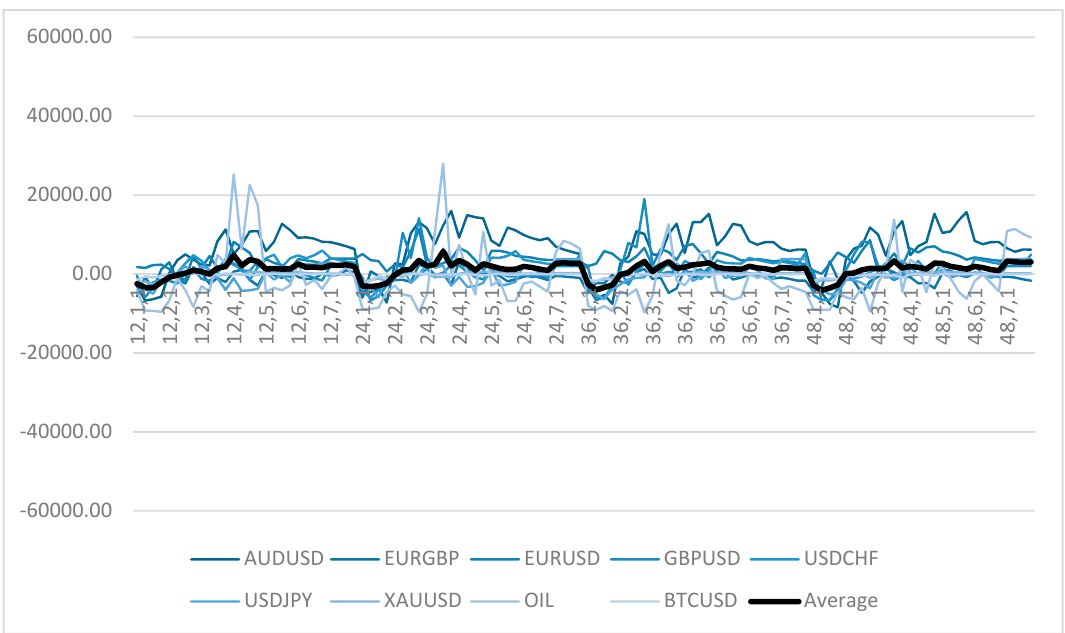
Figure 12. Net Profits of experiment (f) for various combinations of N, x , y .